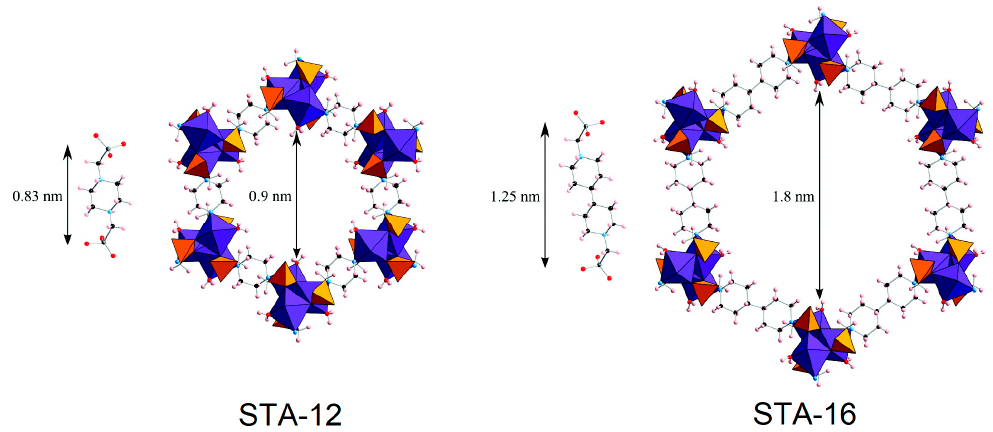
Figure 13. Crystal structures of ( left ) STA-12, based on N,N’ -piperazinediphosphonic acid ( left ) and ( right ) STA-16, based on N,N’ -bispiperidinediphosphonic acid (right). Colour code: cobalt, nickel: purple, phosphorus: orange, oxygen: red, nitrogen: light blue, carbon: black, hydrogen: white. Adapted with permission from reference [72]. Copyright 2011, American Chemical Society.